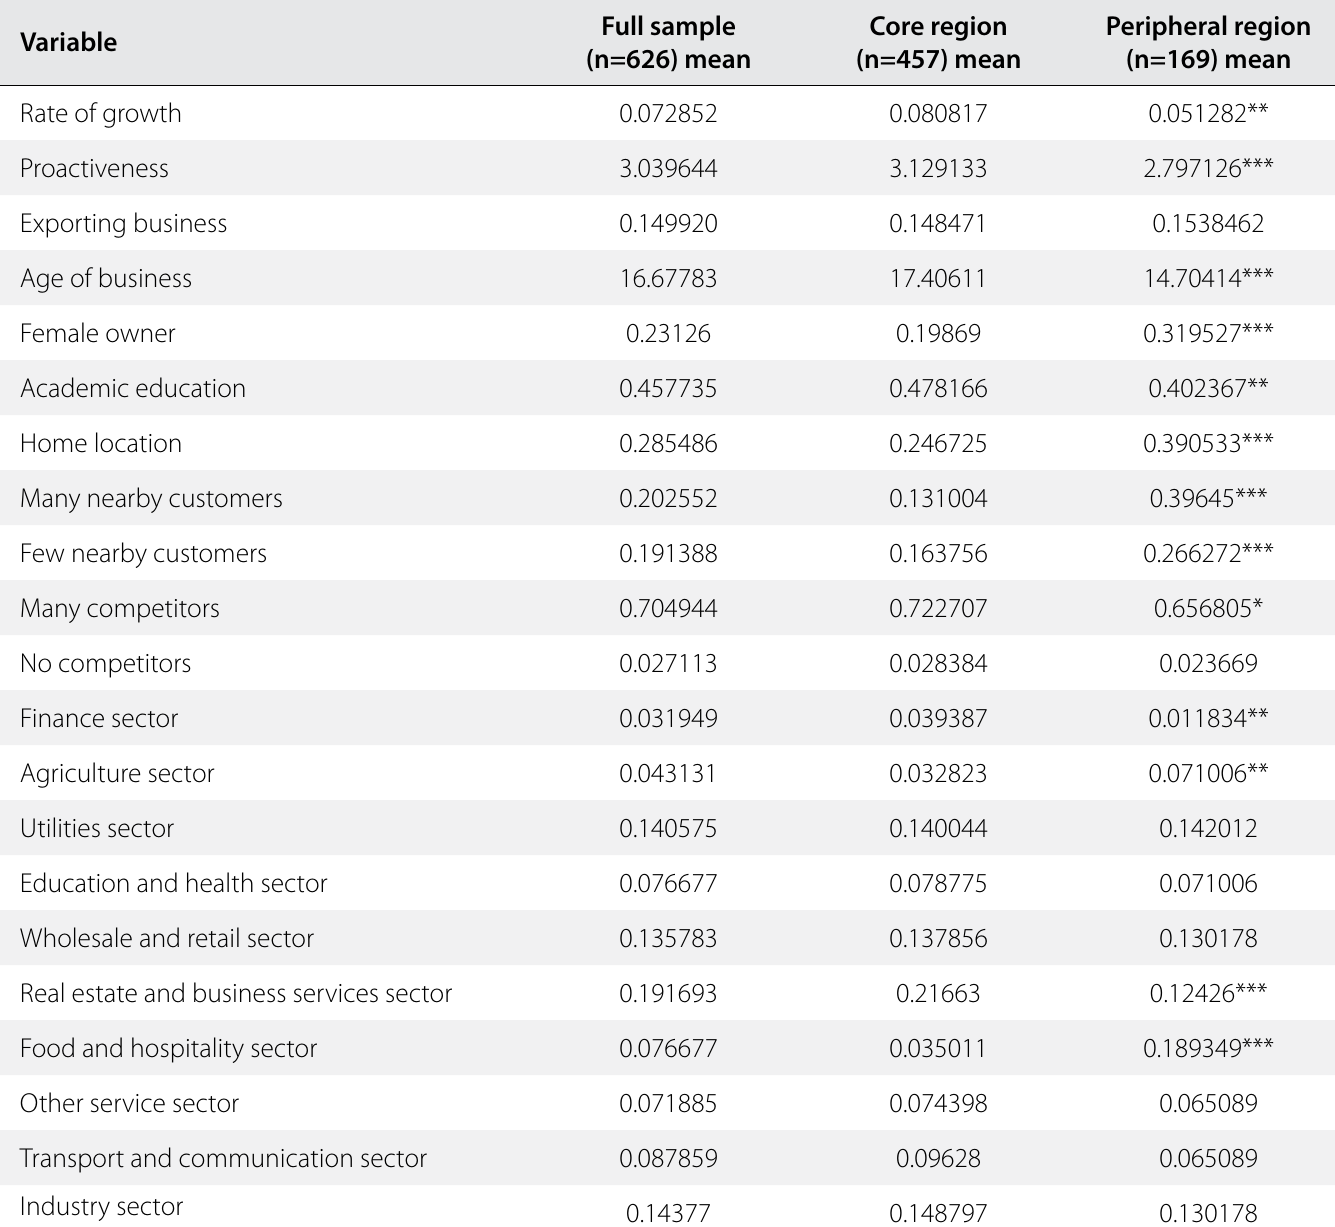
Table 1: Summary